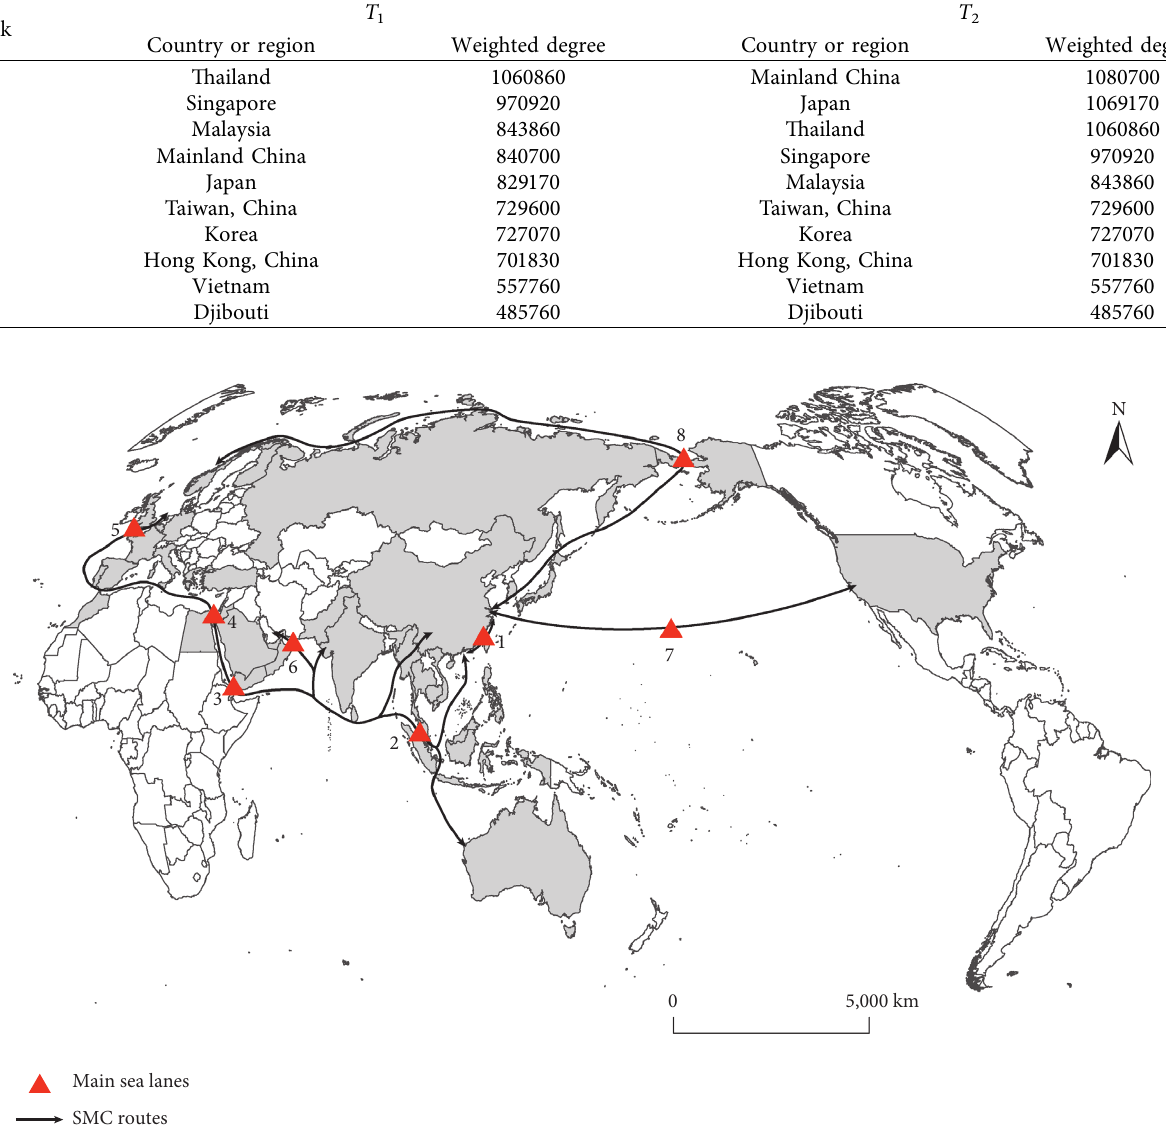
Table 3: Top ten countries or regions with the largest weighted degree.